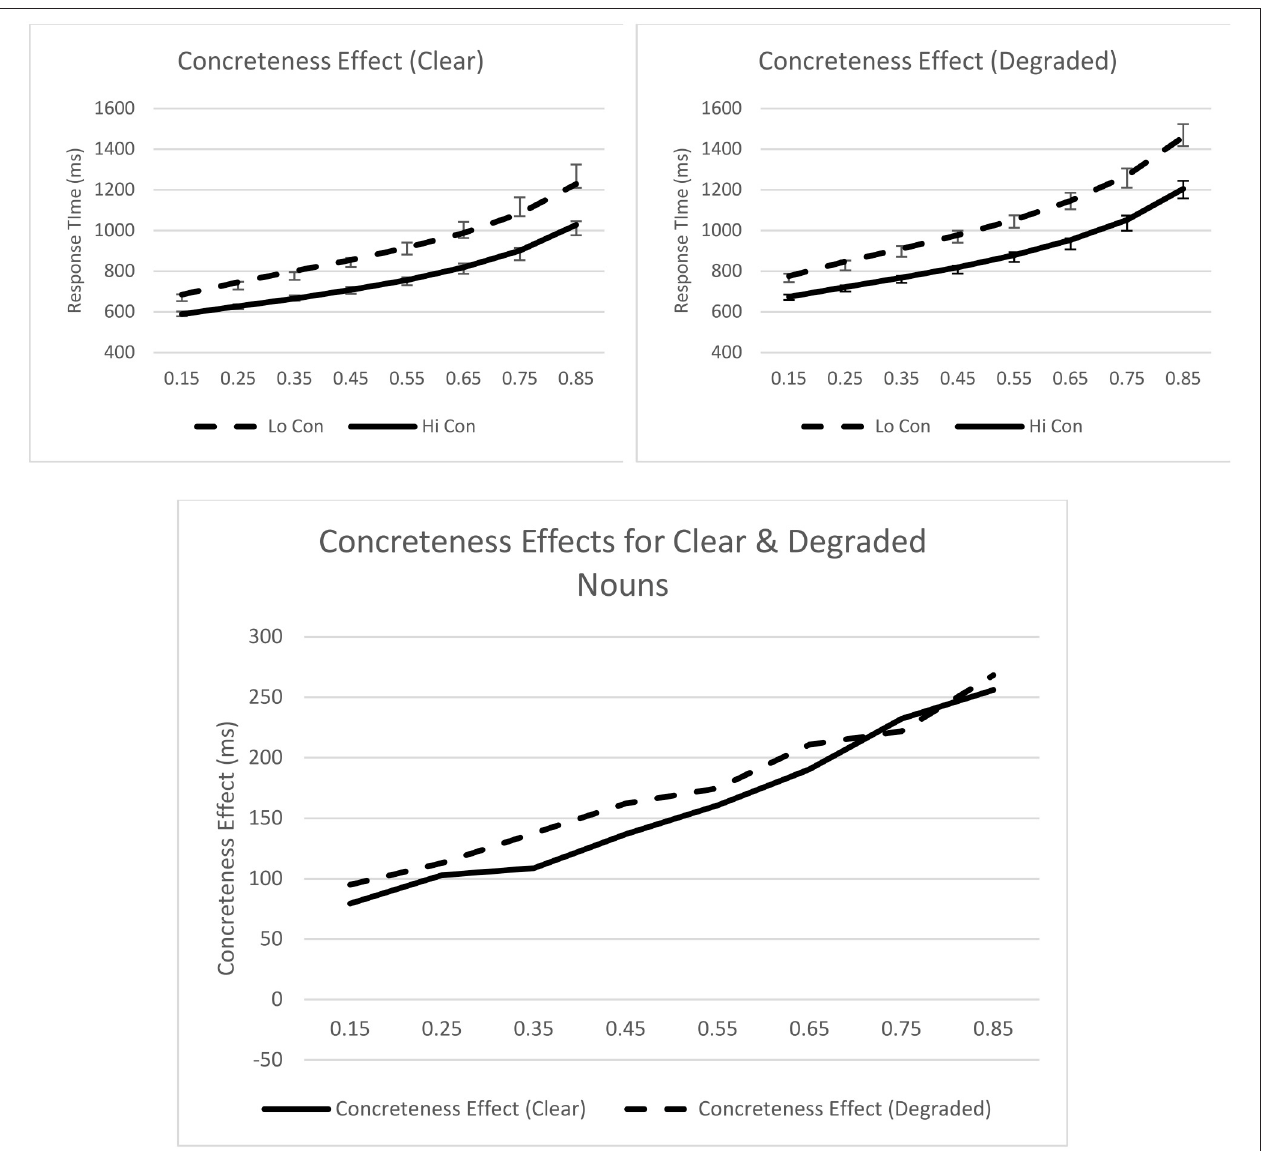
FIGURE 1 | Syntactic classification performance as a function of concreteness and quantiles for clear (top left panel) and degraded (top right panel) words. Empirical quantiles are represented by error bars, whereas fitted ex-Gaussian quantiles are represented by lines. The bottom panel shows concreteness effects as a function of stimulus quality. Con,